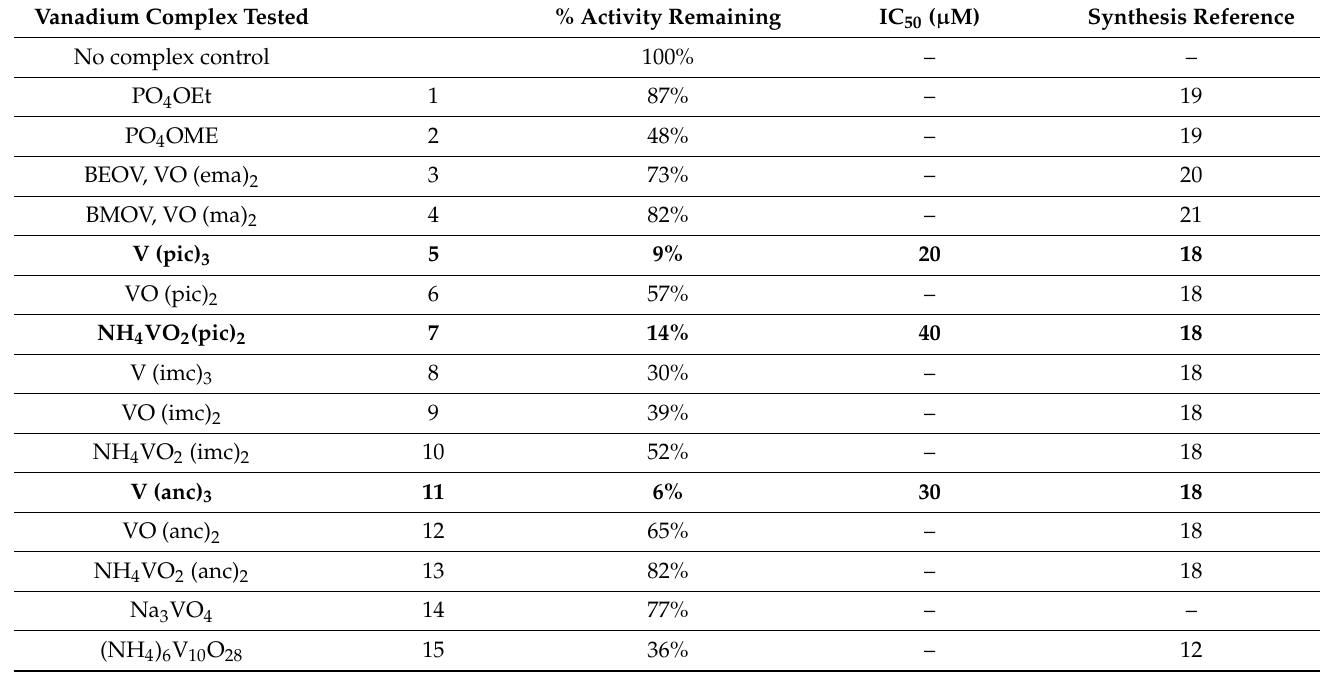
Table 1. Results from CNPase enzyme assay showing percent of activity remaining in the presence of vanadium complexes (10–100 µ M). The complexes demonstrating the greatest degree of inhibition are shown in bold with indicated IC 50 values. The plots for these three complexes are shown in the Supplemental Materials Figure